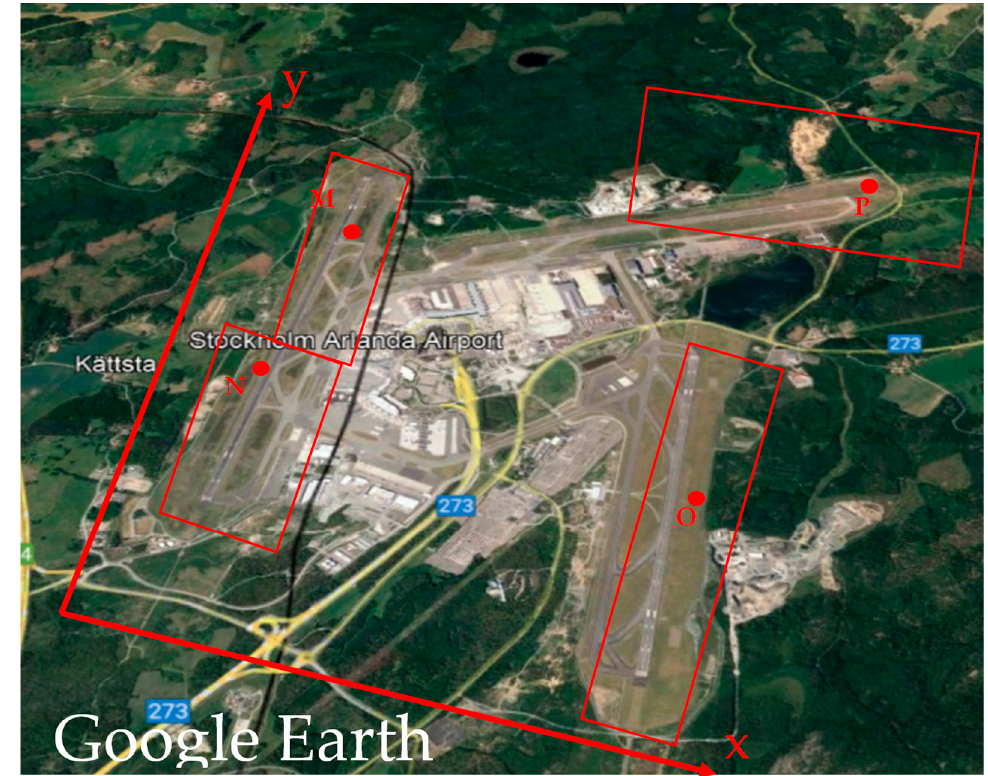
Figure 1. The local coordinate system, monitoring stations (MSs) and search areas of the MSs on the satellite photo, taken from Google Earth, of the Arlanda international airport of Sweden.